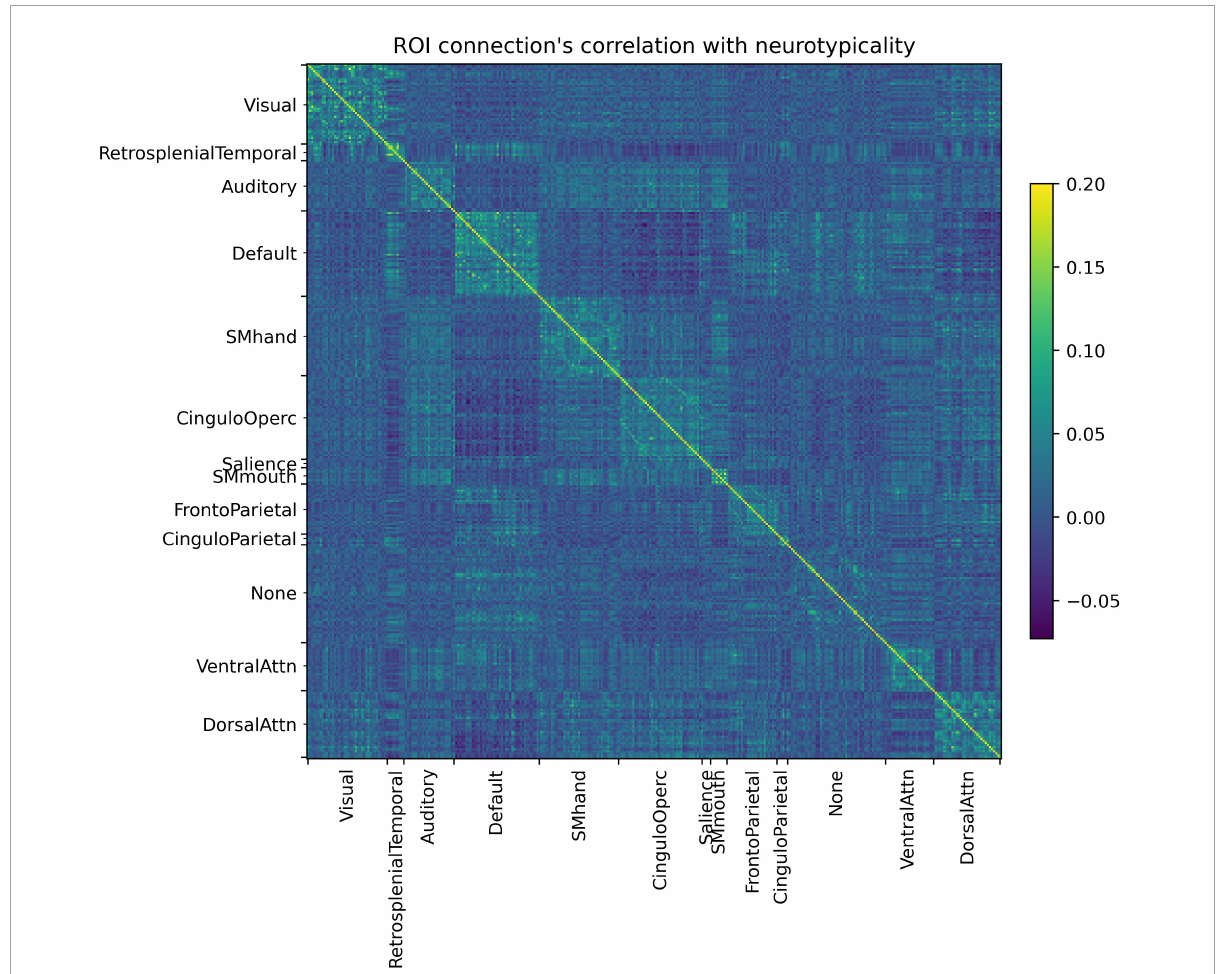
FIGURE4 Regions of interest (ROI) connections’ correlation with neurotypicality label. The complex pattern observed justifies the use of a machine learning model, as no direct associations can be made directly from